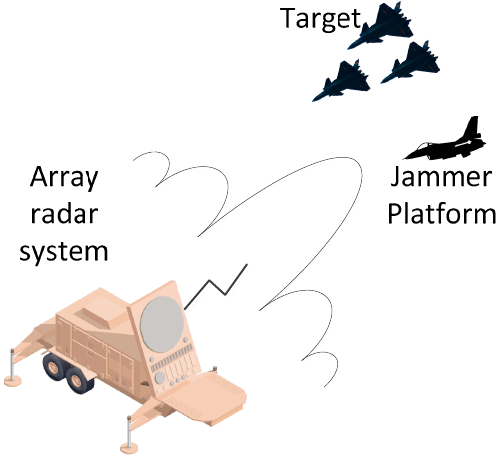
Figure 1. Mainlobe jamming scenario in electronic warfare.